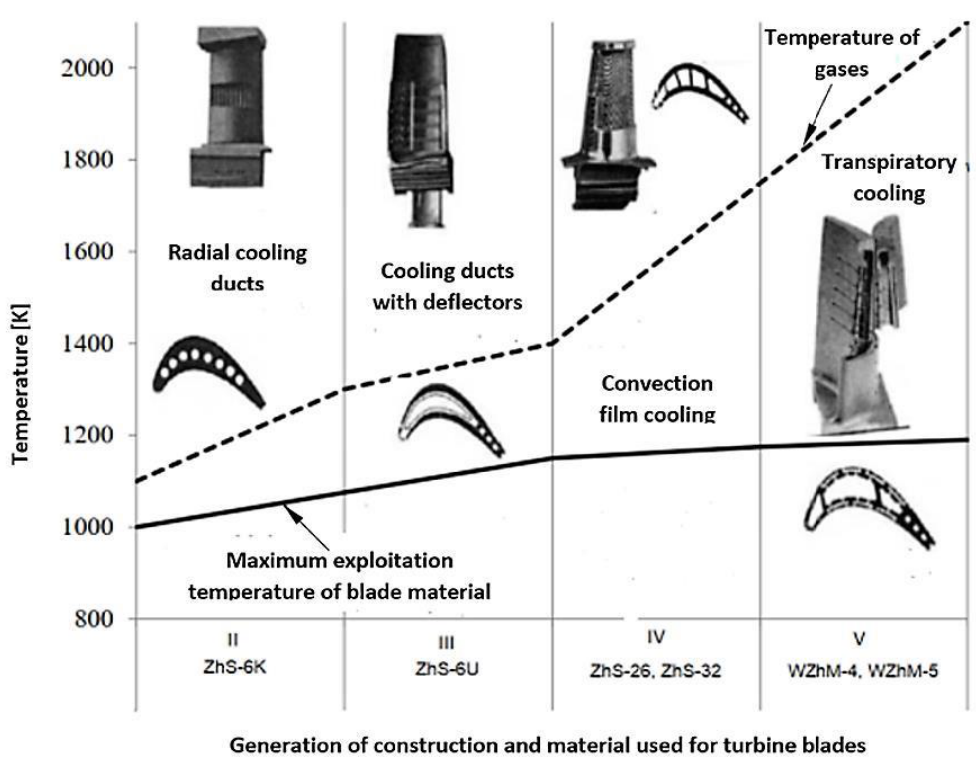
Figure 1. Development of the cooling technology and change in materials used to construct Russian turbine jet engines [3].